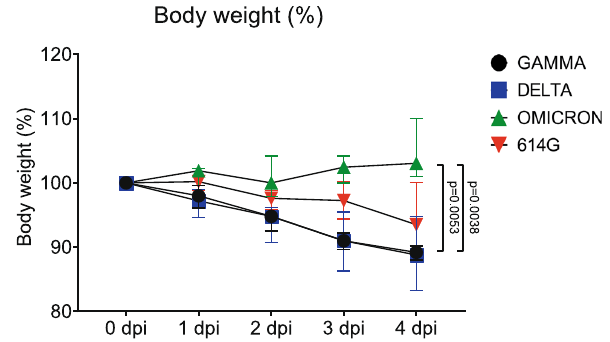
Fig. 1 VOC Omicron infection in hamsters does not cause weight loss. Severe acute respiratory syndrome coronavirus-2 (SARS-CoV-2) variants of concern, Gamma and Delta infected hamsters showed marked weight loss of 10.8% and 11.2%, respectively. SARS-CoV-2 614 G infected hamsters revealed a moderate weight loss of 6.5%, whereas Omicron infected hamsters showed a mild increase in body weight averaging 3.1%. Data points indicate the group median, error bars indicate minima and maxima. The difference was signi fi cant comparing VOC Omicron